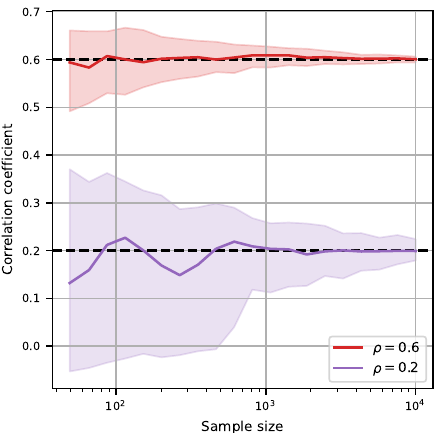
Figure 2. Median and interquartile range of MI correlation coefficient as the sample size increases, for actual correlations 0.6 and 0.2. The low correlation case has more noise from the